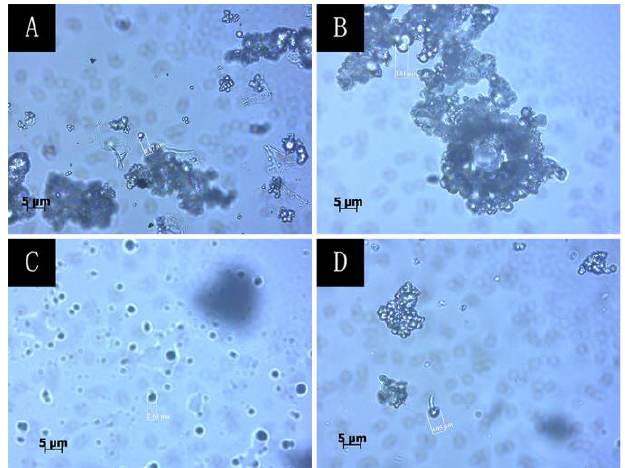
Figure 5. OM of single factor test: ( A ) 400 rpm; ( B ) 600 rpm; ( C ) 800 rpm; ( D ) 1000 rpm.